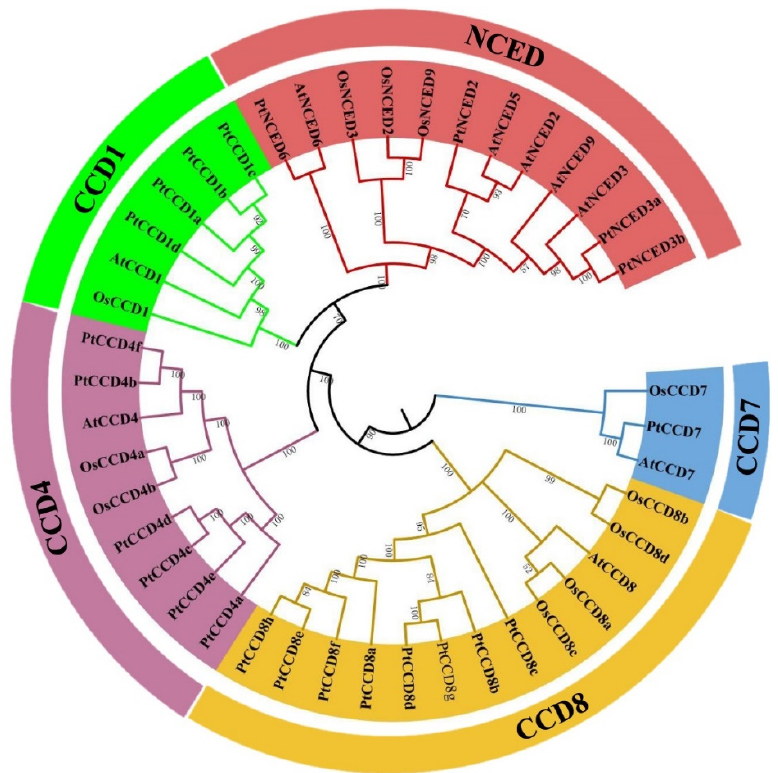
Figure 1. Phylogenetic tree displaying the evolutionary relationships among poplar, Arabidopsis, and rice CCDs. The neighbor-joining (NJ) method tree with 1000 bootstrap replicates was applied to draw a phylogenetic tree with the MEGA7 software. The CCD from poplar, Arabidopsis, and rice were involved in CCD and NCED families, and the CCD family were clustered into CCD1, 4, 7, and 8 classes.